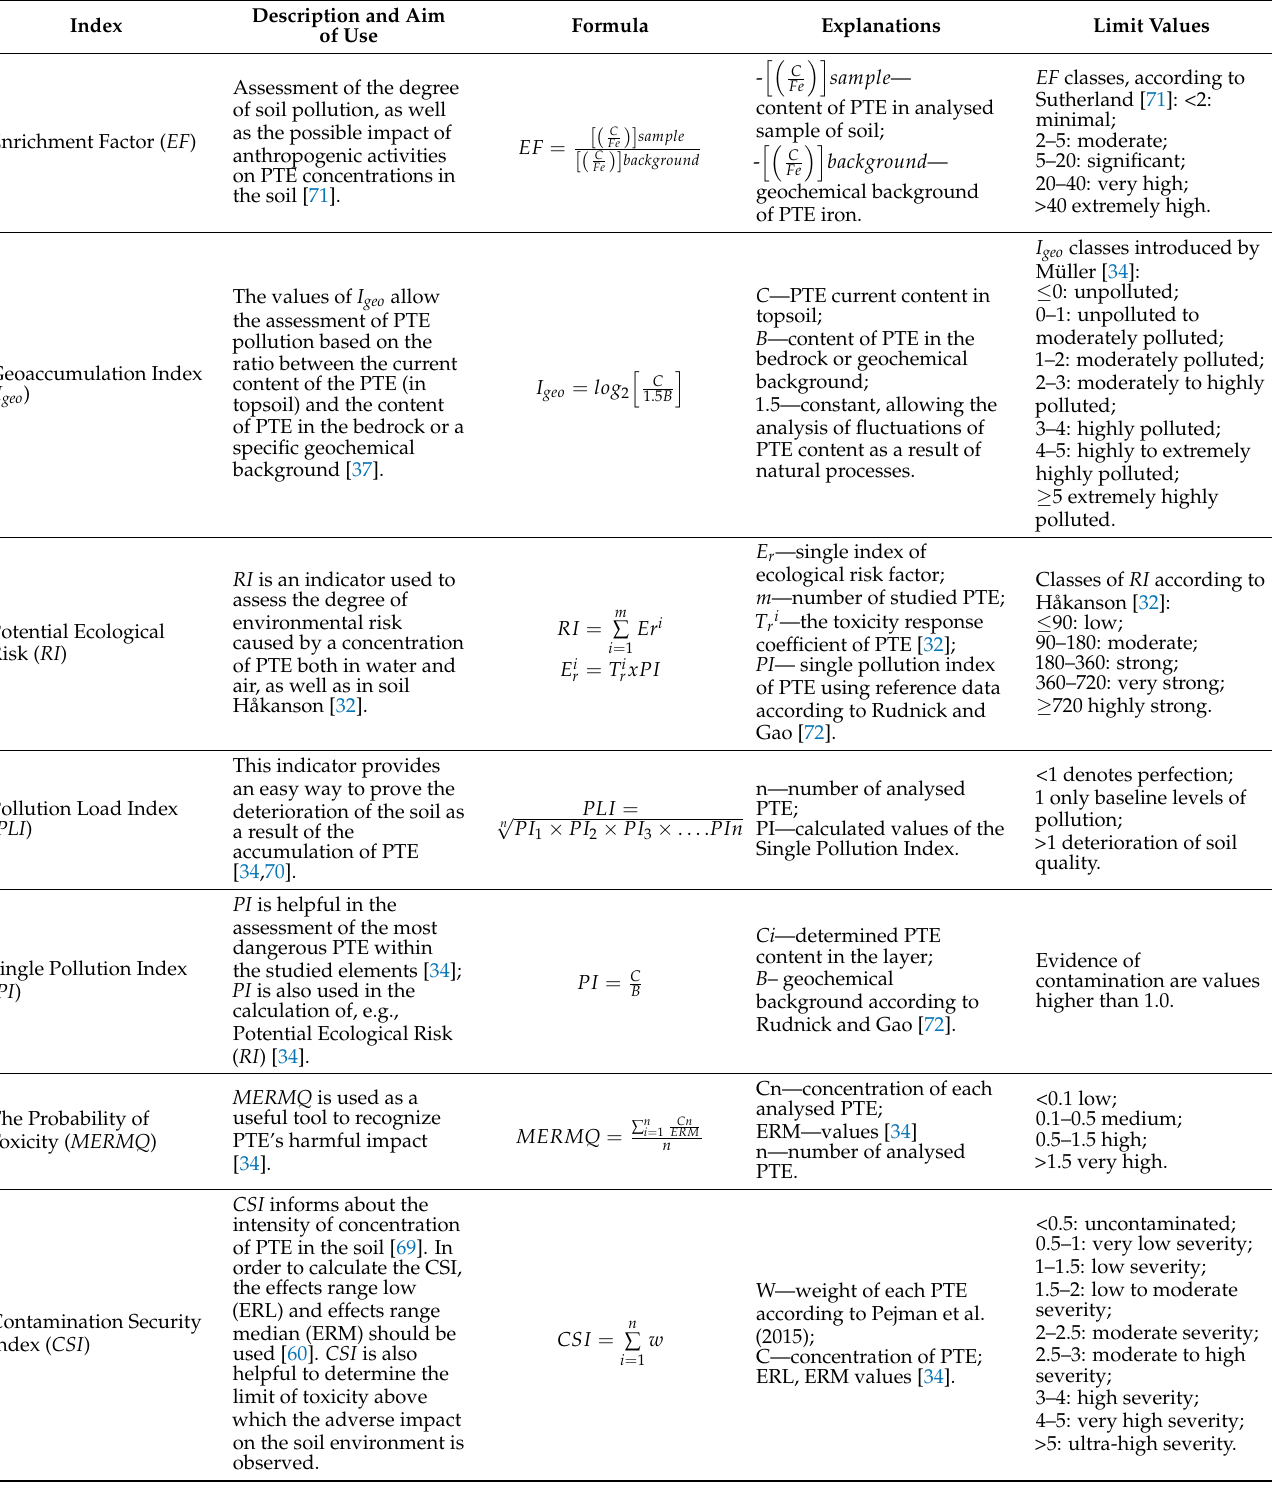
Table 1. Indices of pollution used in this